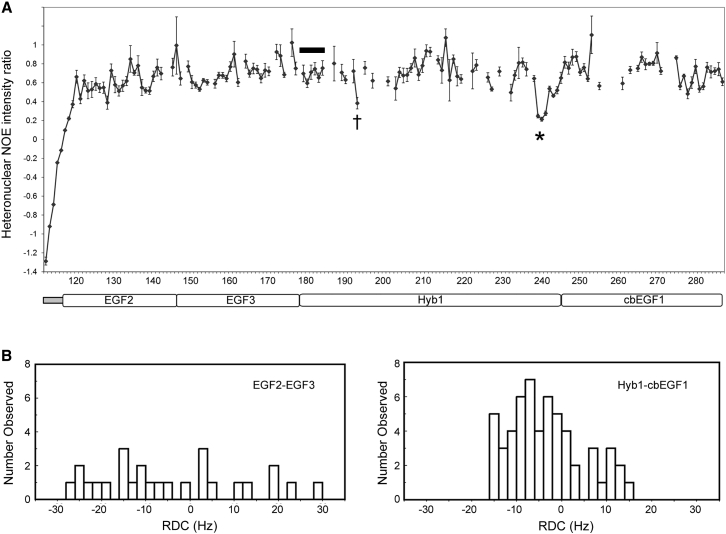
Heteronuclear NOE and RDC Data for FBN1E2cbEGF1(A) {1H}-15N heteronuclear NOE ratios are plotted as a function of sequence for FBN1E2cbEGF1. Low heteronuclear NOE ratios (<0.5) at the N terminus of EGF2 and for two loops in Hyb1 (†, ∗) indicate significant flexibility on a picosecond to nanocsecond timescale in these regions. The residues linking EGF3 to Hyb1, indicated by a thick black line, show NOE ratios characteristic of a rigid protein backbone demonstrating that the EGF3-Hyb1 linker is not flexible on a fast timescale. Error bars for the NOE ratio were estimated from 500 Monte Carlo simulations using baseline noise as a measure of the error in the peak heights.(B) Distribution of RDC values measured in 4% bicelles for the EGF2-EGF3 and Hyb1-cbEGF1 domain pairs of FBN1E2cbEGF1. The different distribution of RDC values for the two pairs suggests that there may be some slower timescale flexibility at the EGF3-Hyb1 interface. Similar differences in RDC distribution are observed for RDCs measured in 2.2% C12E6/n-hexanol (data not shown).